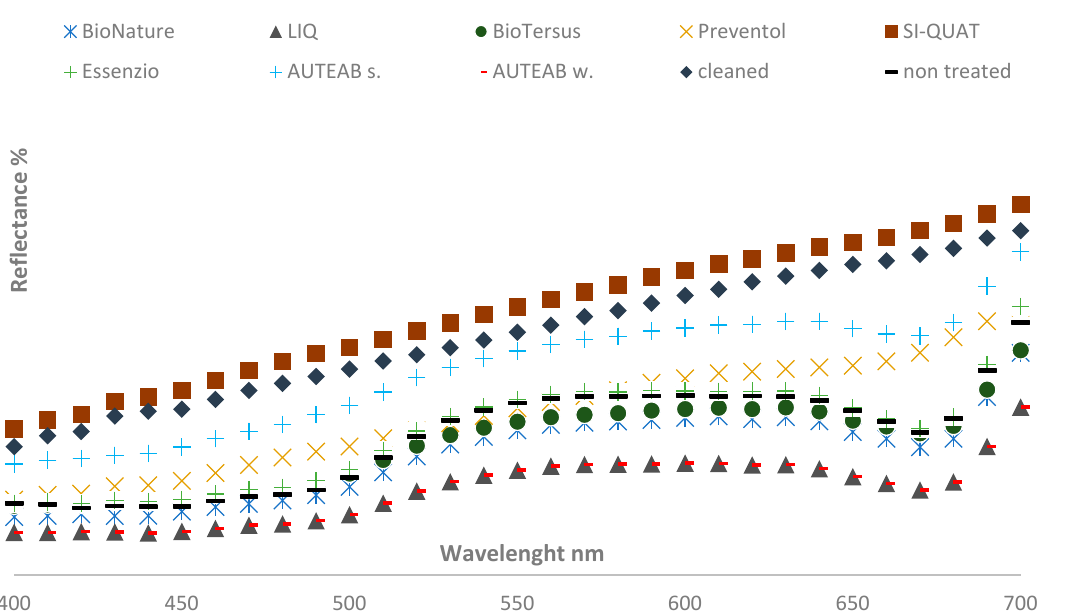
Figure 4. Full spectrum color measurement of treated zones in Area 2. Standard deviaton 0.5 < SD < 3.2.